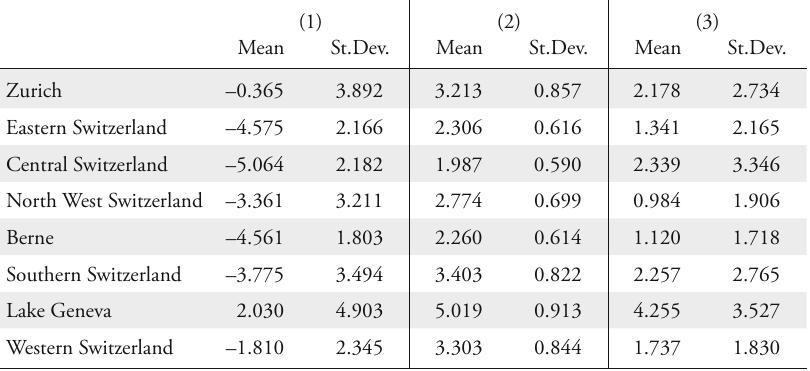
Table 1: Summary